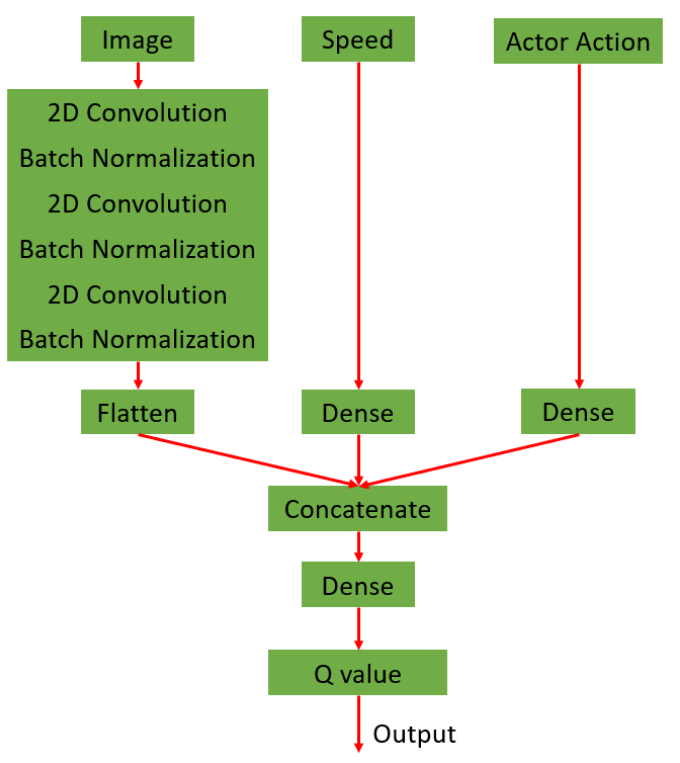
Figure 8. Critic architecture of the